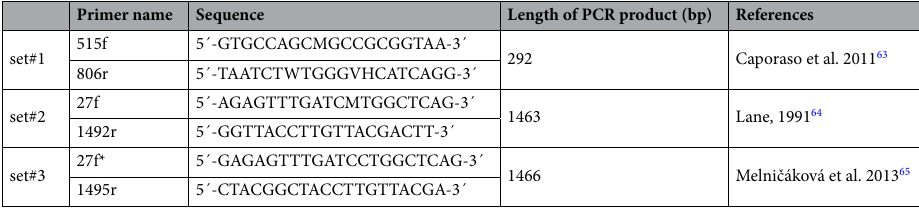
Table 1. Nucleotide sequences of PCR primers.